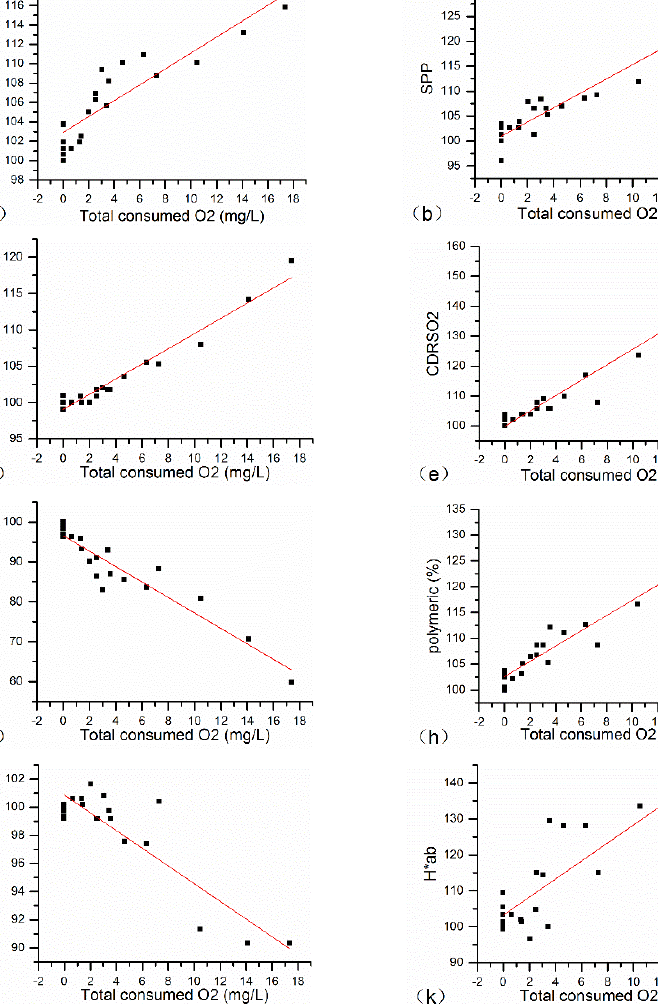
( − 0.56% on average per mg/L of Oxygen consumed).